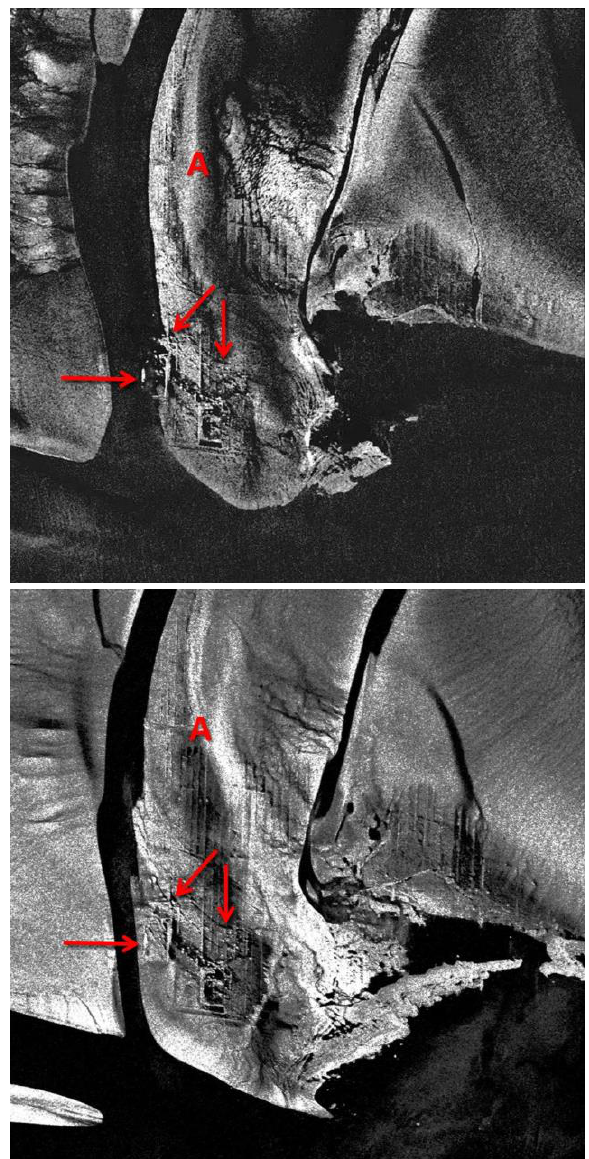
Figure 6. Subsection (1000 m × 1000 m) of two TanDEM-X staring spotlight scenes acquired on 19 November 2014 (upper) and 20 January 2015 (lower), north of Pellworm. The linear structures are cultural traces. The letter (A) is explained in the text, the arrows are inserted for comparison with Figure 7. © DLR 2014,